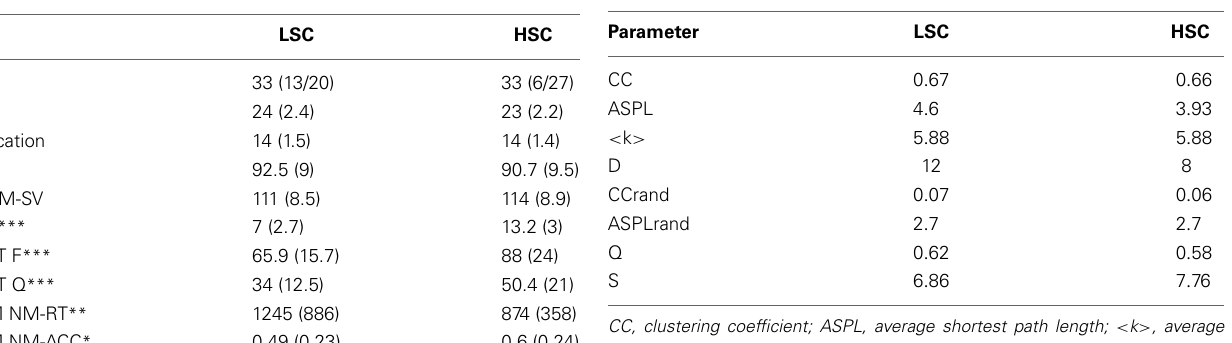
Table 2 | Low Semantic Creative (LSC) and High Semantic Creative (HSC) group details (standard deviations in brackets).